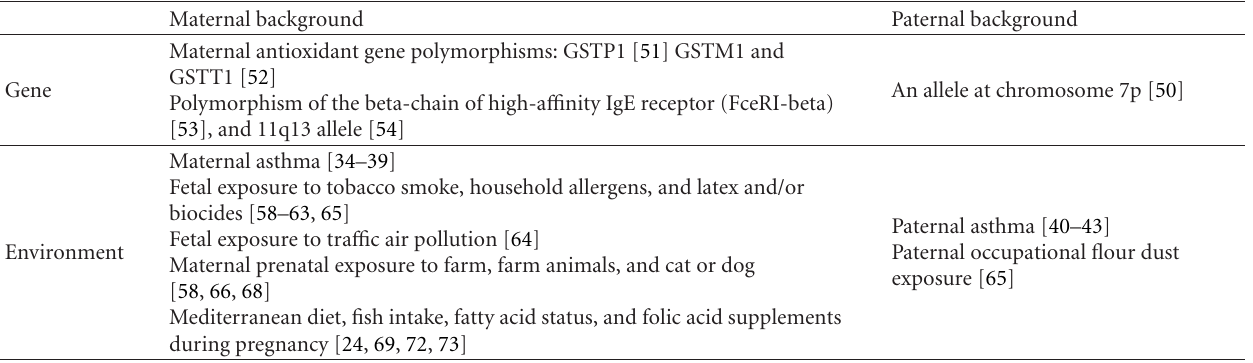
Table 2: E ff ect of parental background on IgE production and asthma